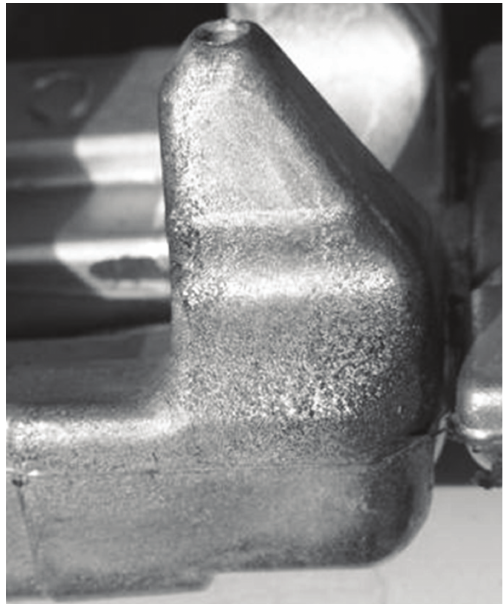
Figure 5: An example of the rough surface finish of a lubricant defect brake caliper casting produced during trials with the CSIR- RCS-HPDC cell.